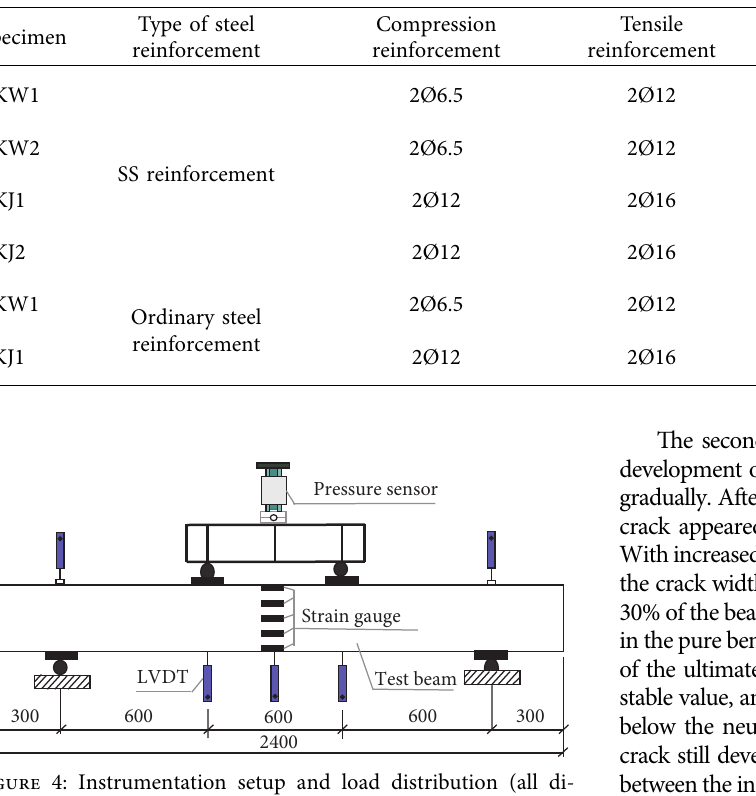
Table 3: Types and specifications of the steel